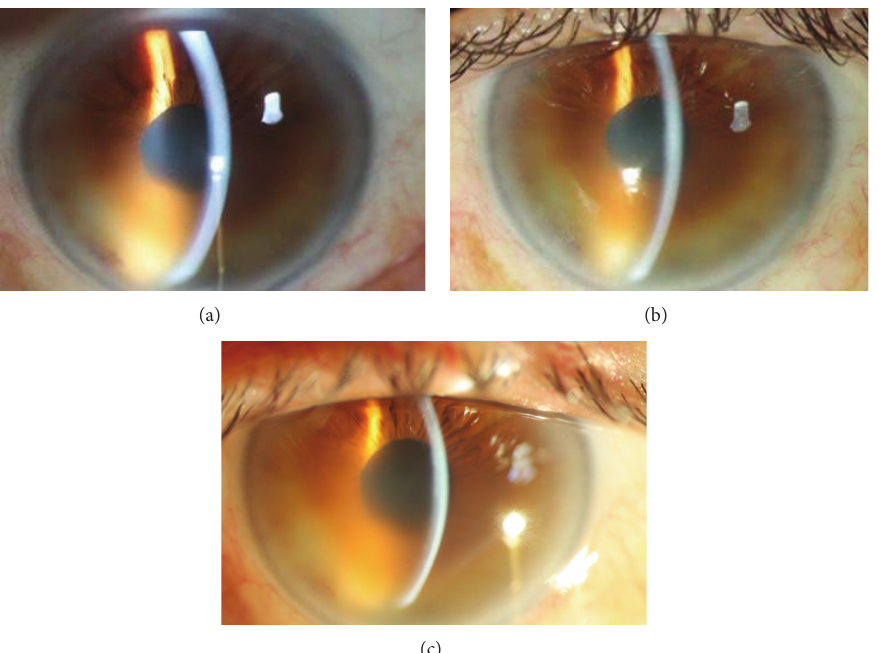
Figure 2: (a) Case 2: slit lamp biomicroscopy picture of the right eye before CXL. (b) Case 2: slit lamp biomicroscopy picture of the right eye 12 months after CXL. (c) Case 2: slit lamp biomicroscopy picture of the right eye 3 months after repeat